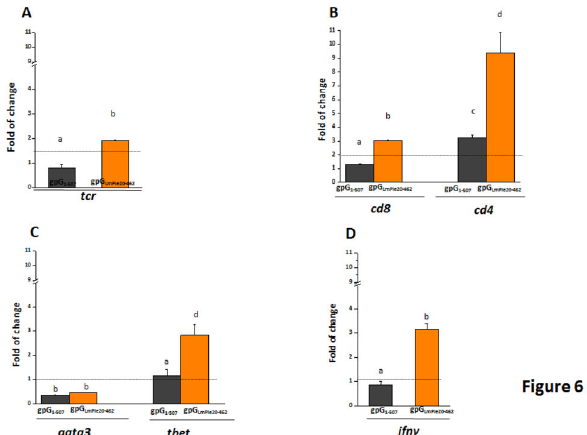
Figure 5. Transcripts levels of pax5 , igm and igt in peritoneal cells 3 days after immunisation. Levels of pax5 (A), igm and igt (B) transcript levels estimated by RT-qPCR in fish i.p. injected with 2 µg of either pAE6-gpG gpG (orange bars). Bars represent the mean fold changes and SD of pools of 3 fish per group. Fold increases were LmPle20-462 calculated relative to the level of non-immunised fish (injected with PBS). Different letters denote statistically significant differences between the groups according to a Tukey’s test.